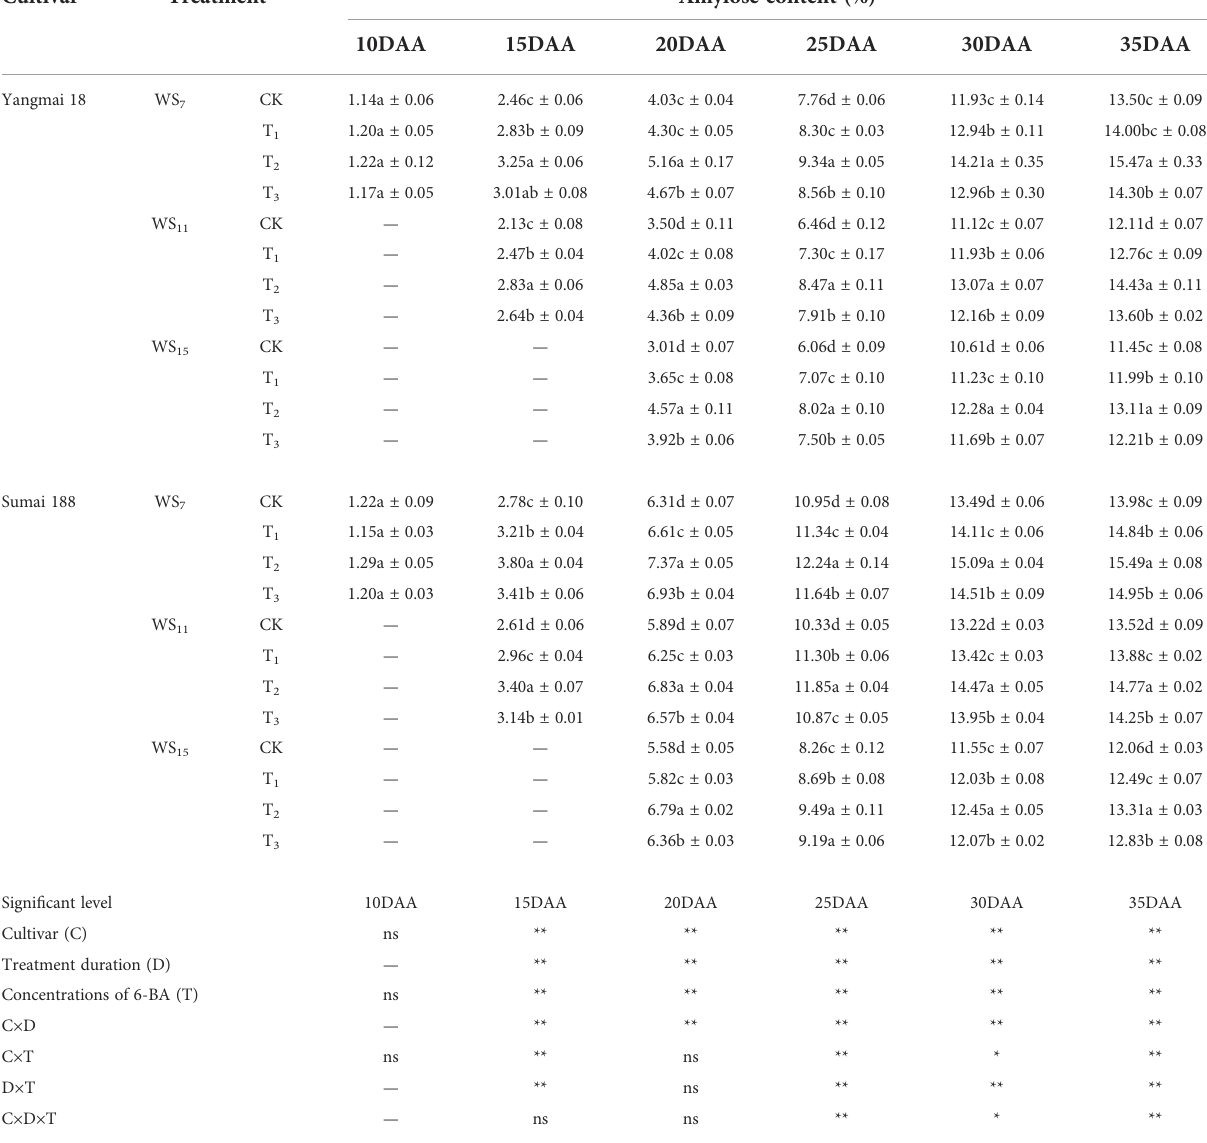
TABLE 2 The effect of exogenous 6-BA on amylose accumulation of wheat under waterlogging and shading in 2021. Cultivar